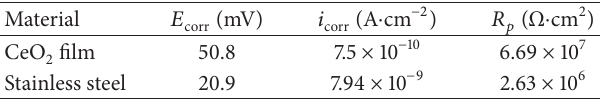
film and stainless